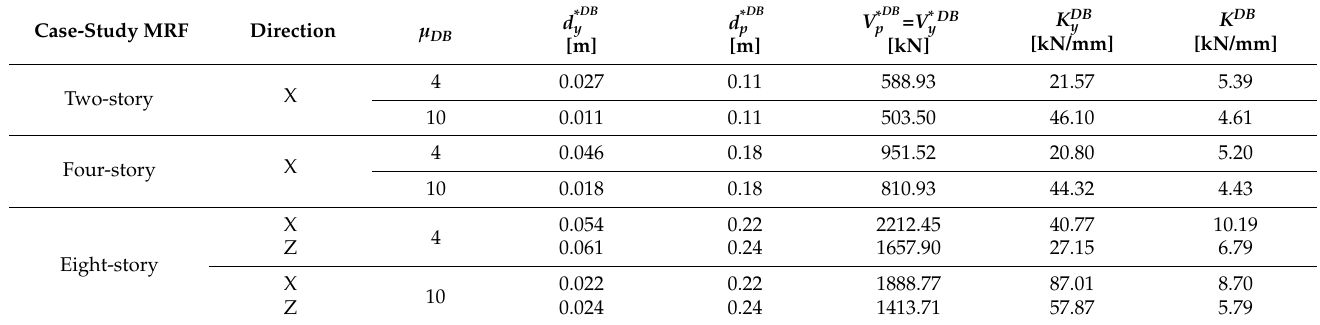
Table 3. Properties of the equivalent SDOF damped braces ( 𝑑 (cid:3052)∗ (cid:3005)(cid:3003) yield displacement; 𝑑 (cid:3043)∗(cid:3005)(cid:3003) ultimate displacement equal to the MRF target displacement 𝑑 (cid:3043)∗ ; 𝑉 (cid:3043)∗ (cid:3253)(cid:3251) (cid:3404) 𝑉 (cid:3052)∗(cid:3005)(cid:3003) ultimate and yield force; 𝐾 (cid:3052)(cid:3005)(cid:3003) (cid:3404) 𝑉 (cid:3052)∗ (cid:3253)(cid:3251) / 𝑑 (cid:3052)∗(cid:3005)(cid:3003) elastic stiffness; 𝐾 (cid:3005)(cid:3003) (cid:3404) 𝑉 (cid:3043)∗ (cid:3253)(cid:3251) / 𝑑 (cid:3043)∗(cid:3005)(cid:3003) effective stiffness). Case-study MRF